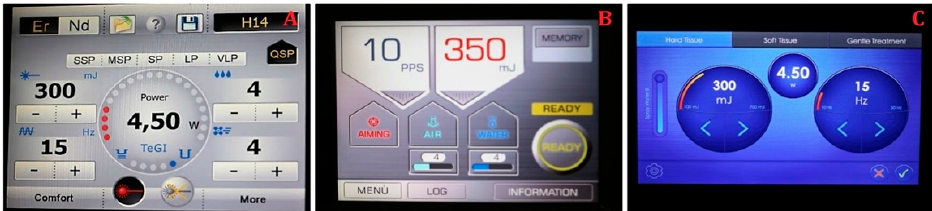
Figure 4. Crown debonding with Er:YAG lasers: ( A ) LightWalker ( B ) AvErL Evo ( C ) Litetouch.